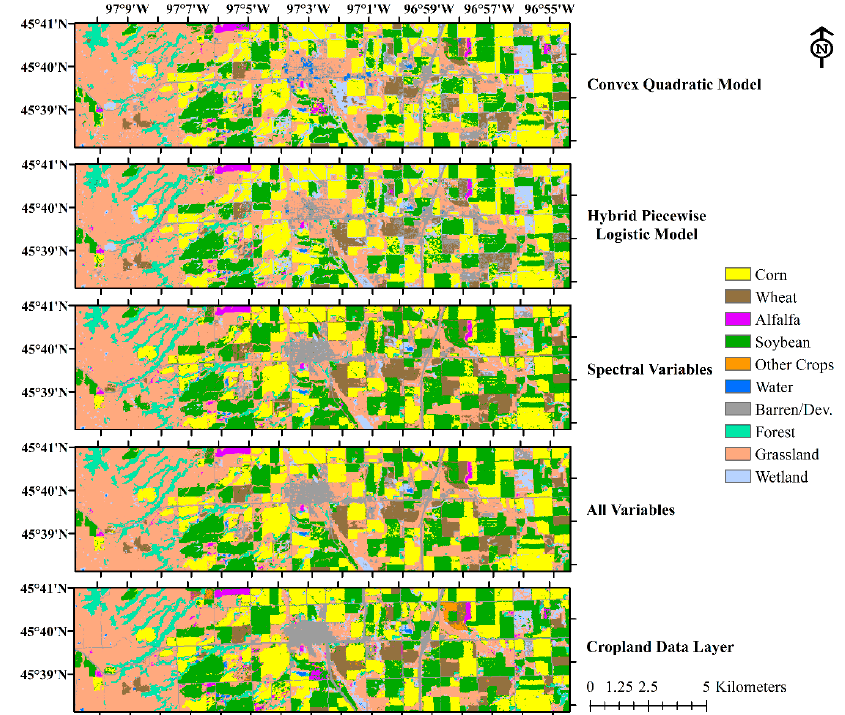
Figure 3. 2016 ARD-based land cover maps of area around Sisseton, the county seat of Roberts County, South Dakota. Note the barren / developed class in the phenometrically-based RFC maps (CxQ and HPLM) is not as accurate as in the SPL or CMB RFC maps.